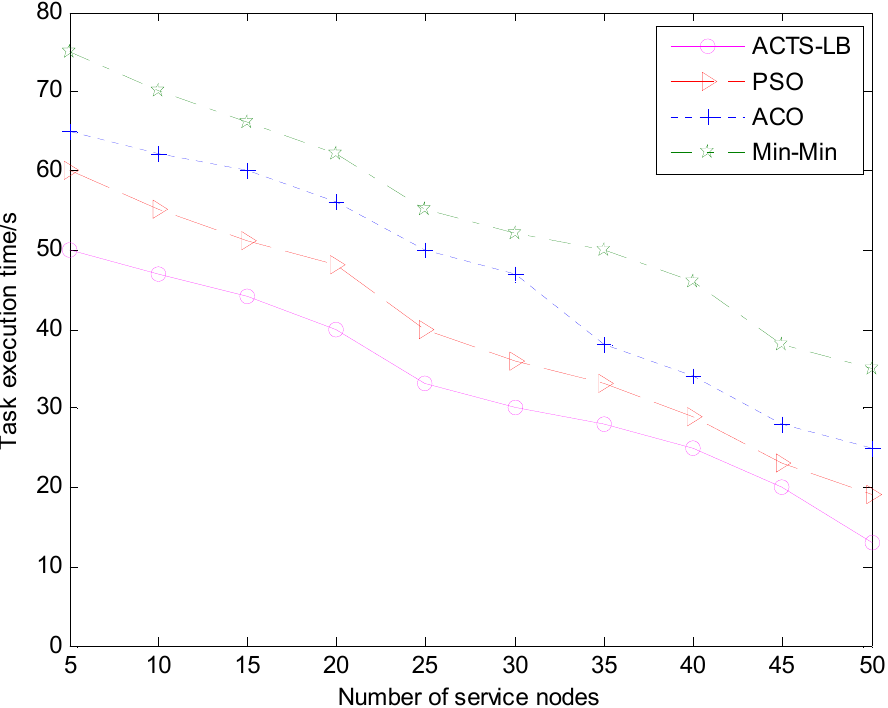
Figure 7. The comparison of task execution time span under different scheduling tasks.